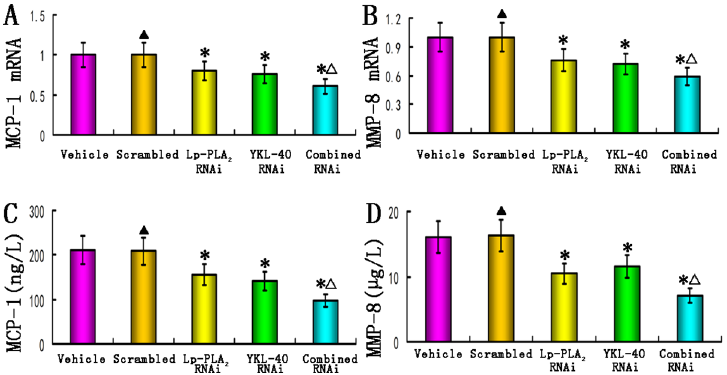
Fig 5. Effects of RNAi on inflammation markers in vivo . (A) mRNA expression of MCP-1 in the plaques of the vehicle, scrambled, Lp-PLA 2 RNAi, YKL-40 RNAi, and combined Lp-PLA 2 and YKL-40 RNAi groups (n = 12); (B) mRNA expression of MMP-8 in the plaques from all groups (n = 12); (C) The concentrations of MCP-1 in the plasma from all groups (n = 24). (D) The concentrations of MMP-8 in the plasma from all groups (n = 24). (cid:3) P < 0.05 vs. vehicle groups; ▲ P > 0.05 vs. vehicle group; 4 P < 0.05 vs. Lp-PLA 2 RNAi and YKL-40 RNAi groups.